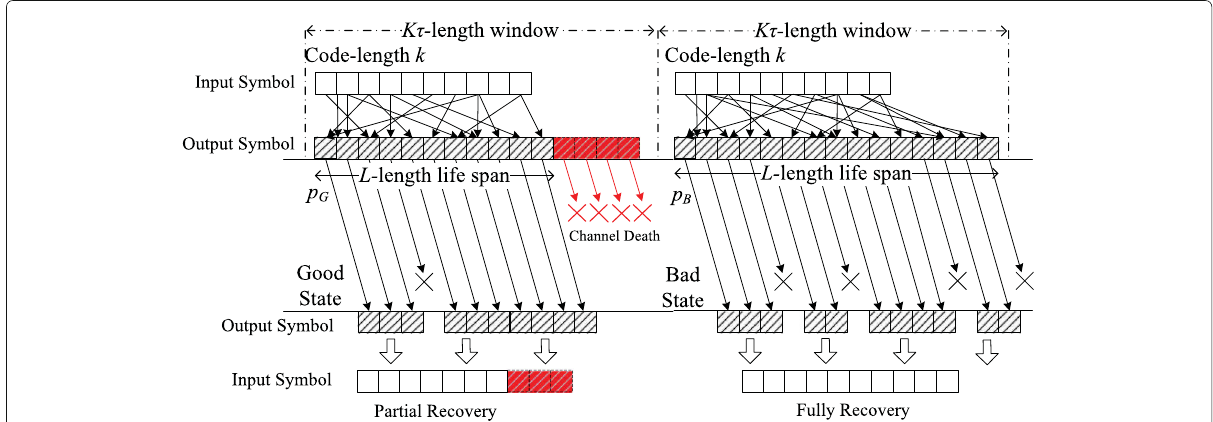
Fig. 2 Rateless coding transmission over MDEC. The rateless decoder may fully or partially recover the input symbols, according to the number of successfully received output symbols in one